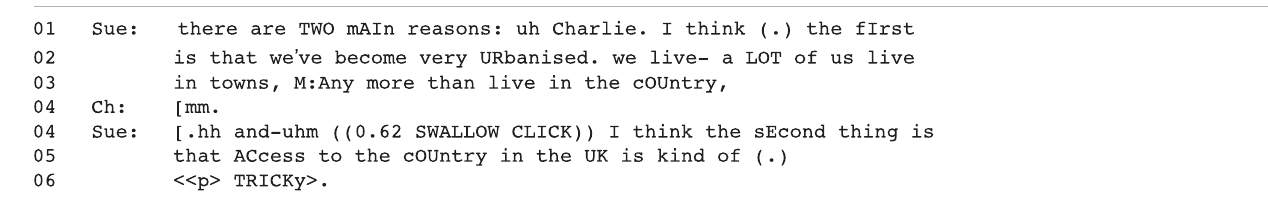
Example 1: Vegtalk BBC Radio 4 19.12.03